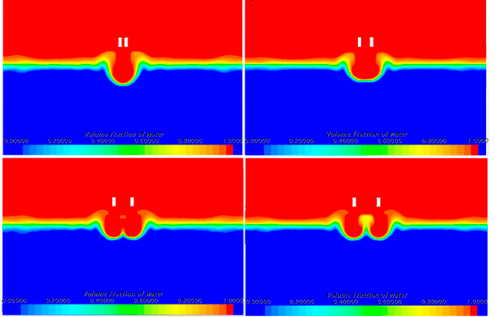
Figure 14. The correlation curve of scour width and jet angle.